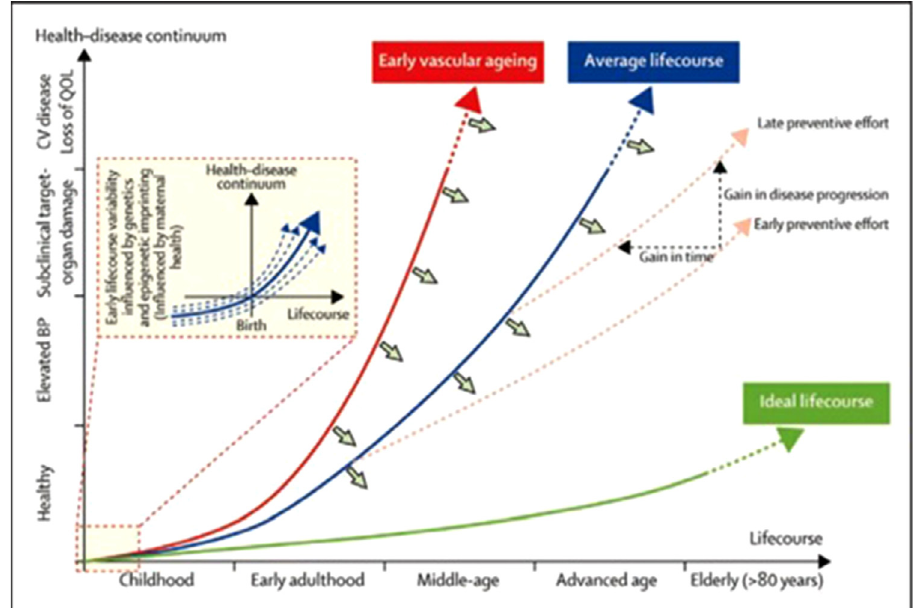
Fig. 2. Adapted from Olsen et al